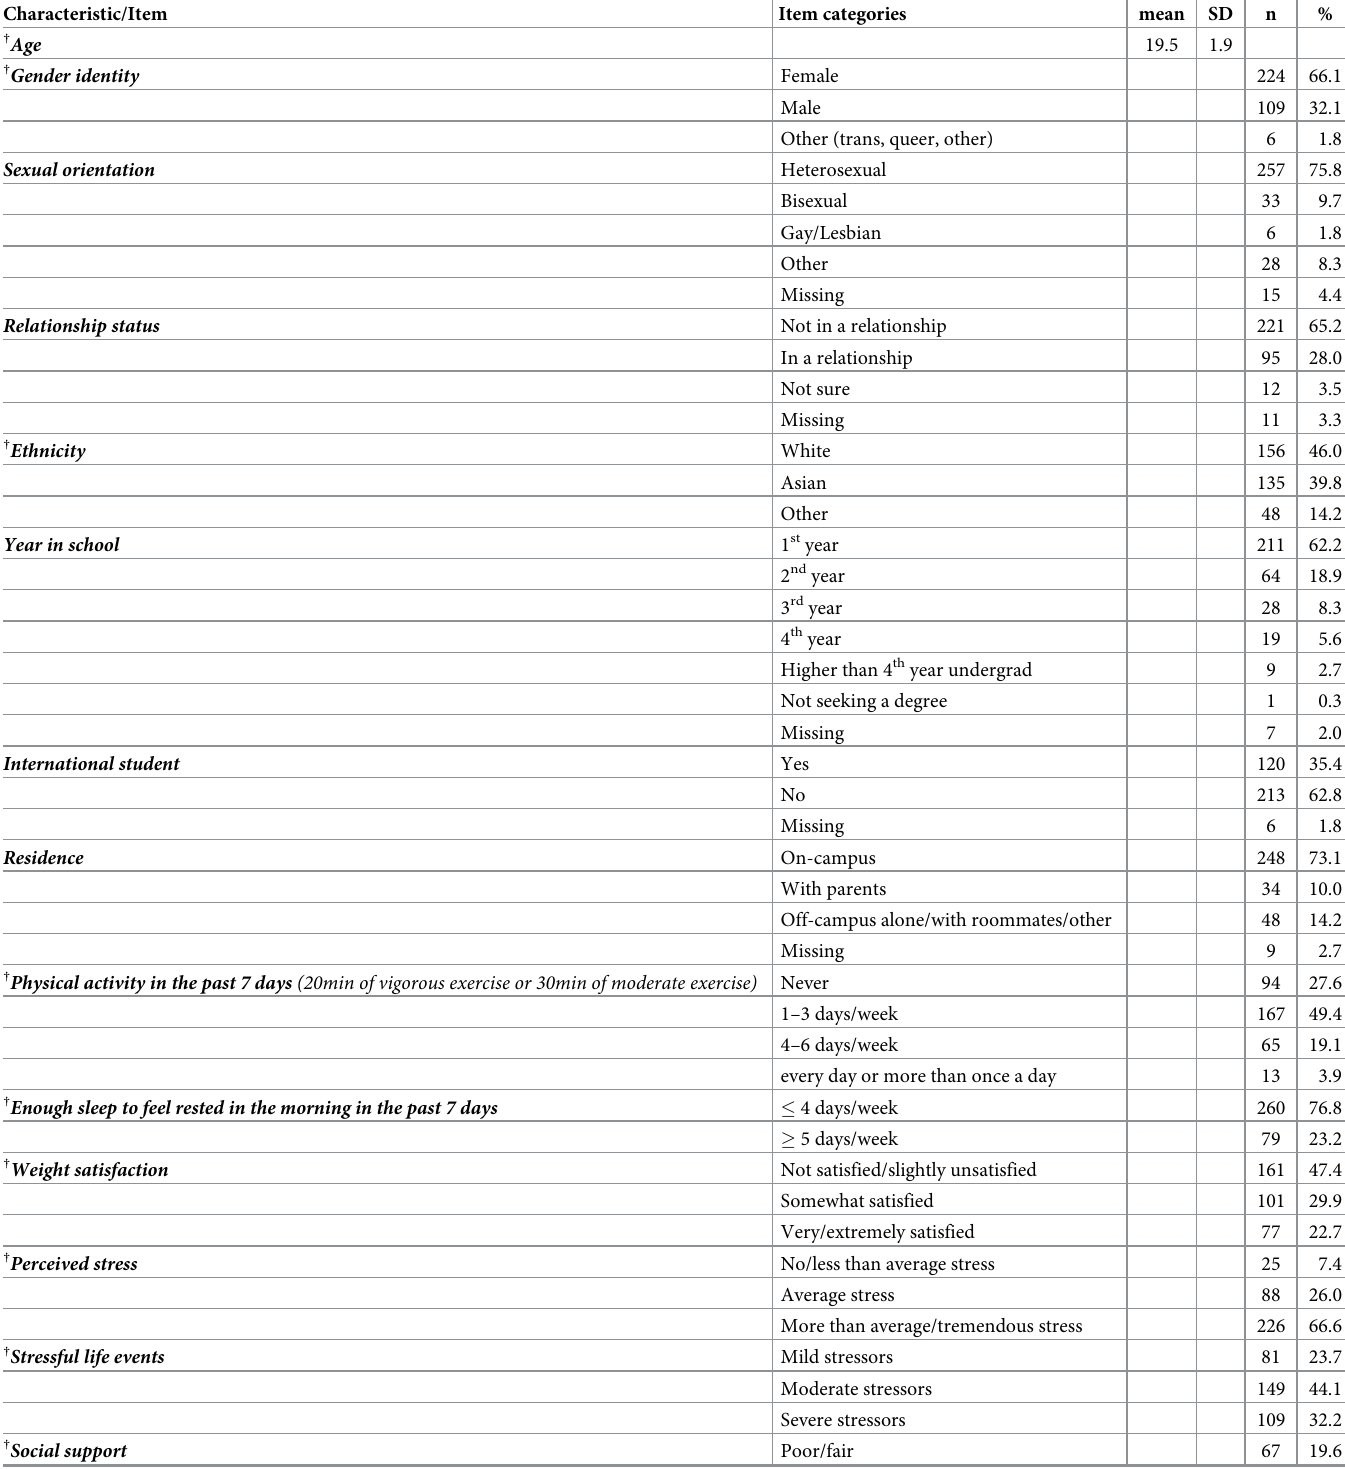
Table 1. Participant demographic and psychosocial characteristics.